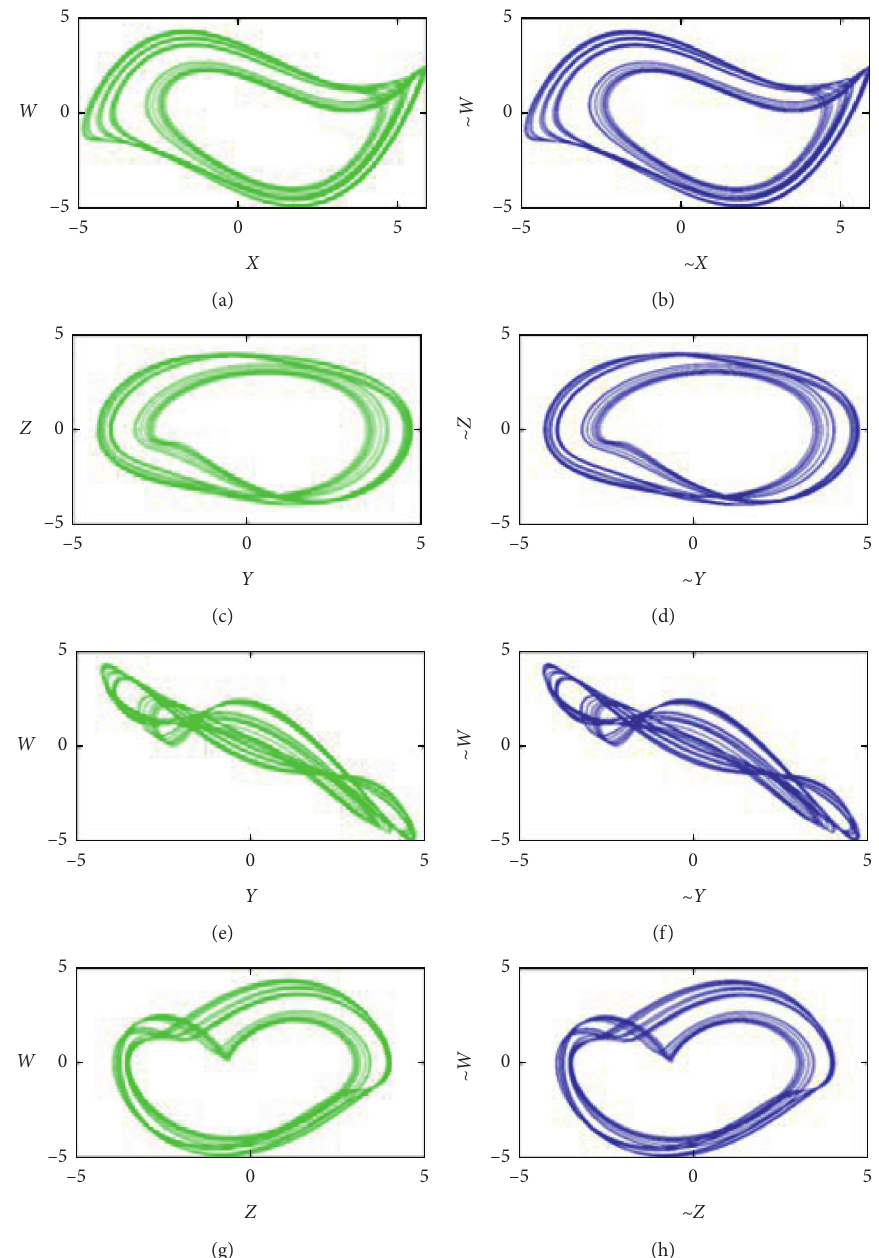
Figure 26: Phase portraits of target data (in green) and artificial neural network output (in